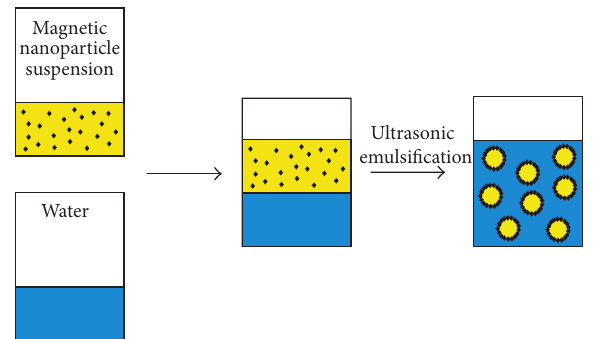
Figure 2: A schematic representation of the preparation method of a magnetic Pickering emulsion.